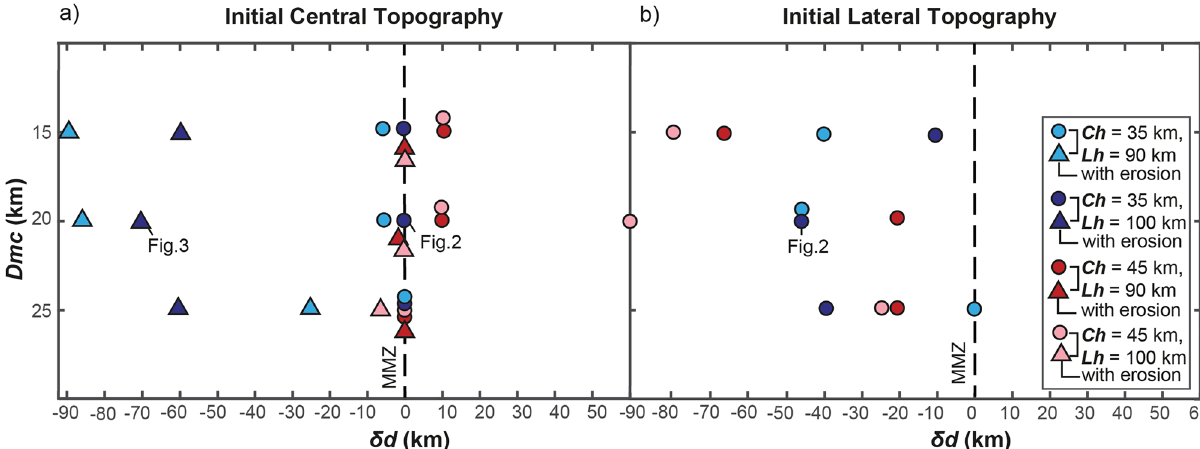
Figure 4. Results of the parametric study. Initial depth of the magmatic channel upper tip (Dmc) vs. δ d (see text), with initial central ( a ) and lateral ( b ) topography. Triangles in panel ( a ) are the results of simulations with asymmetric erosion (i.e., second set of simulations, see text). Negative values show asymmetry to the left of the mantle melting zone (MMZ) (i.e., central vertical axis of the model domain). Values of Ch and Lh are shown in the legend, cold and hot colors show simulations with thin and thick crust, respectively. See results of simulations in Figs. 2, 3, Supplementary Figs. 1–8, and Table